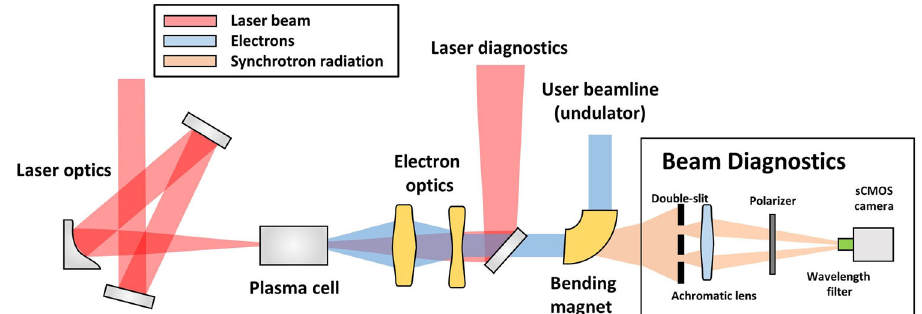
Fig. 1 Schematic layout of the interferometry beam size monitor (IBSM) with a scienti fi c complementary metal – oxide – semiconductor (sCMOS) camera for a plasma-wake fi eld accelerator. The laser beam is separated by an electron-transparent mirror and is transferred to the laser diagnostics beamline to monitor the stability of the plasma. Electrons are guided to the user beamline by a bending magnet and synchrotron radiation is emitted perpendicular to the path in the magnet. The location of the diagnostics is determined to close to the incident angle of the electron beam by considering the bunch lengthening effect within the magnetic fi eld of the